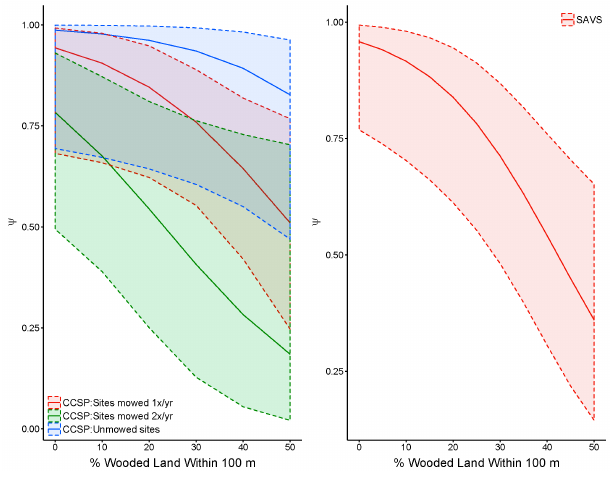
Fig. 5. Predicted relationship for Clay-colored Sparrow (CCSP) and Savannah Sparrow (SAVS) initial probability of site occupancy based on the percentage of land within 100 m of study sites consisting of wooded lands (trees or shrubs). Relationships are as determined by the best-ranked multiseason occupancy model for each species in 2008–2009. Prediction curves for CCSP show declining probability of occupancy ( Ψ ) with increasing mowing frequency at sites.